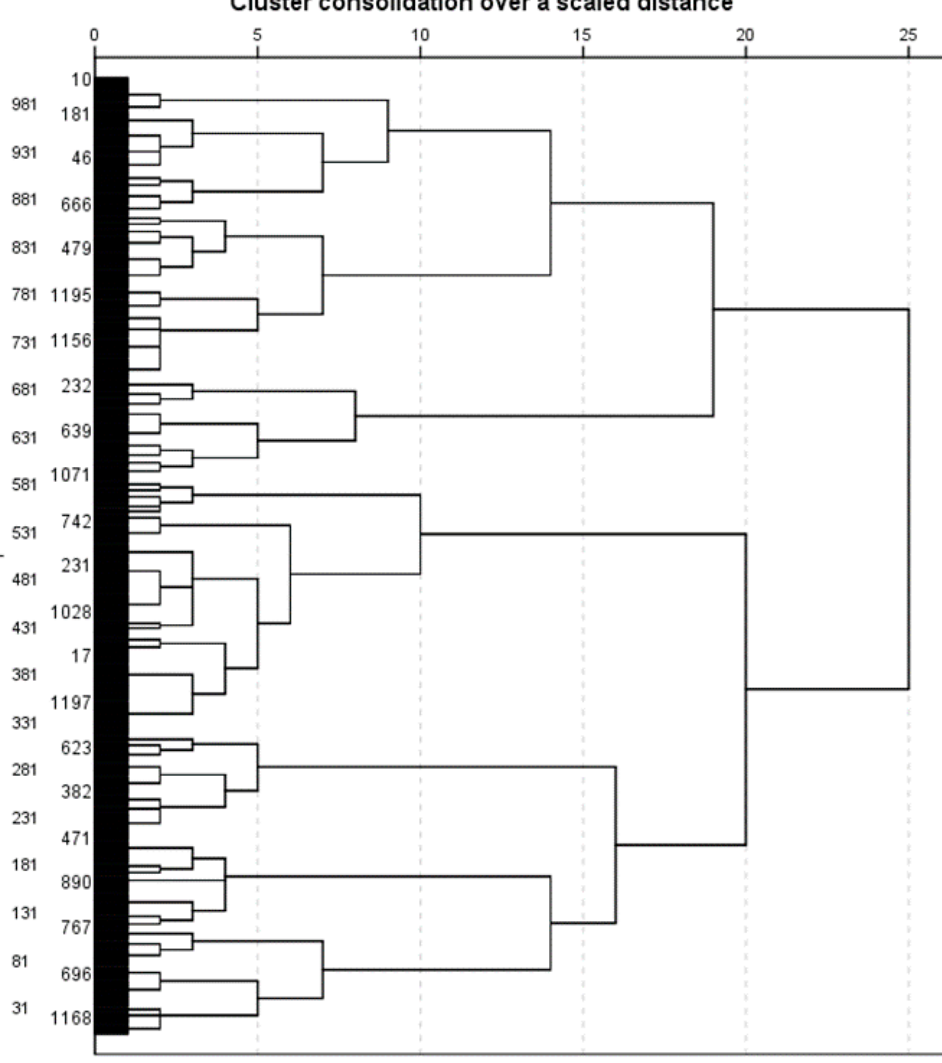
Figure 8. Dendrogram based on the results of cluster analysis of respondents (car owners) on eight factors (Ward’s method).